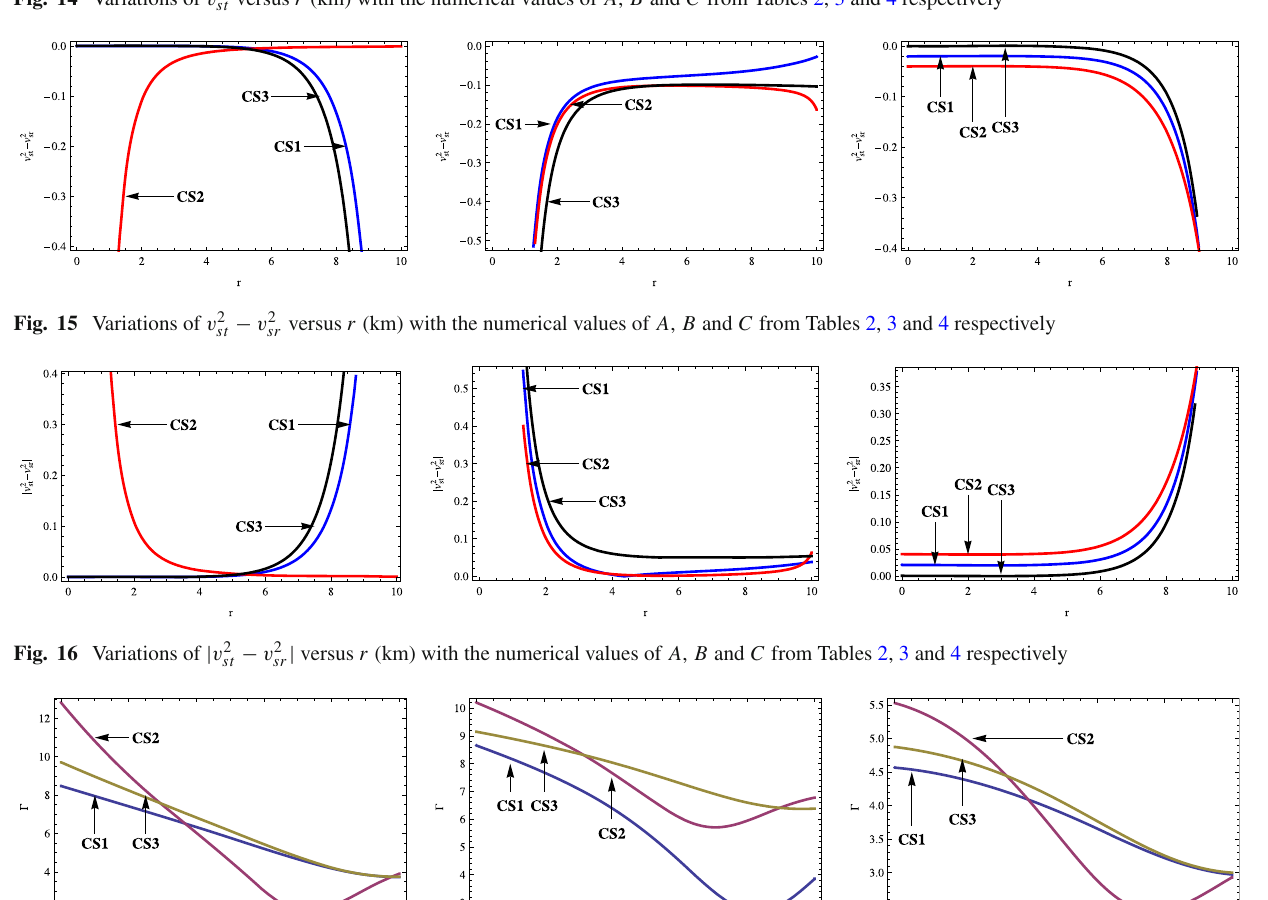
Fig. 14 Variations of v 2 st versus r (km) with the numerical values of A , B and C from Tables 2, 3 and 4 respectively